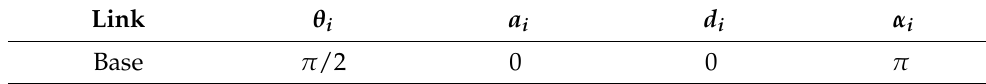
Table A2. DH Parameters relating the base frame to reference frame of Link